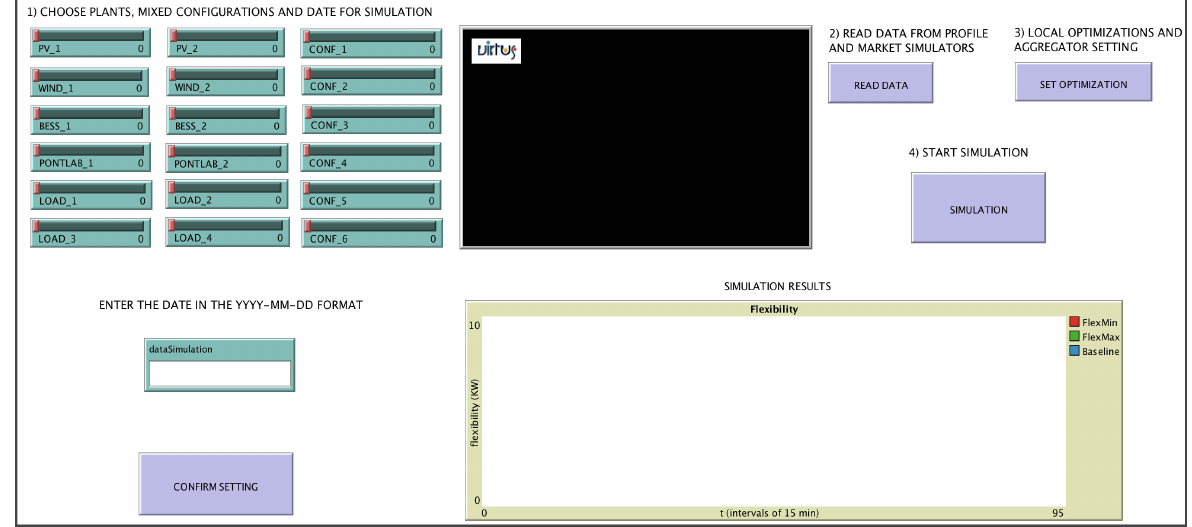
Figure 14. VPP graphical interface in